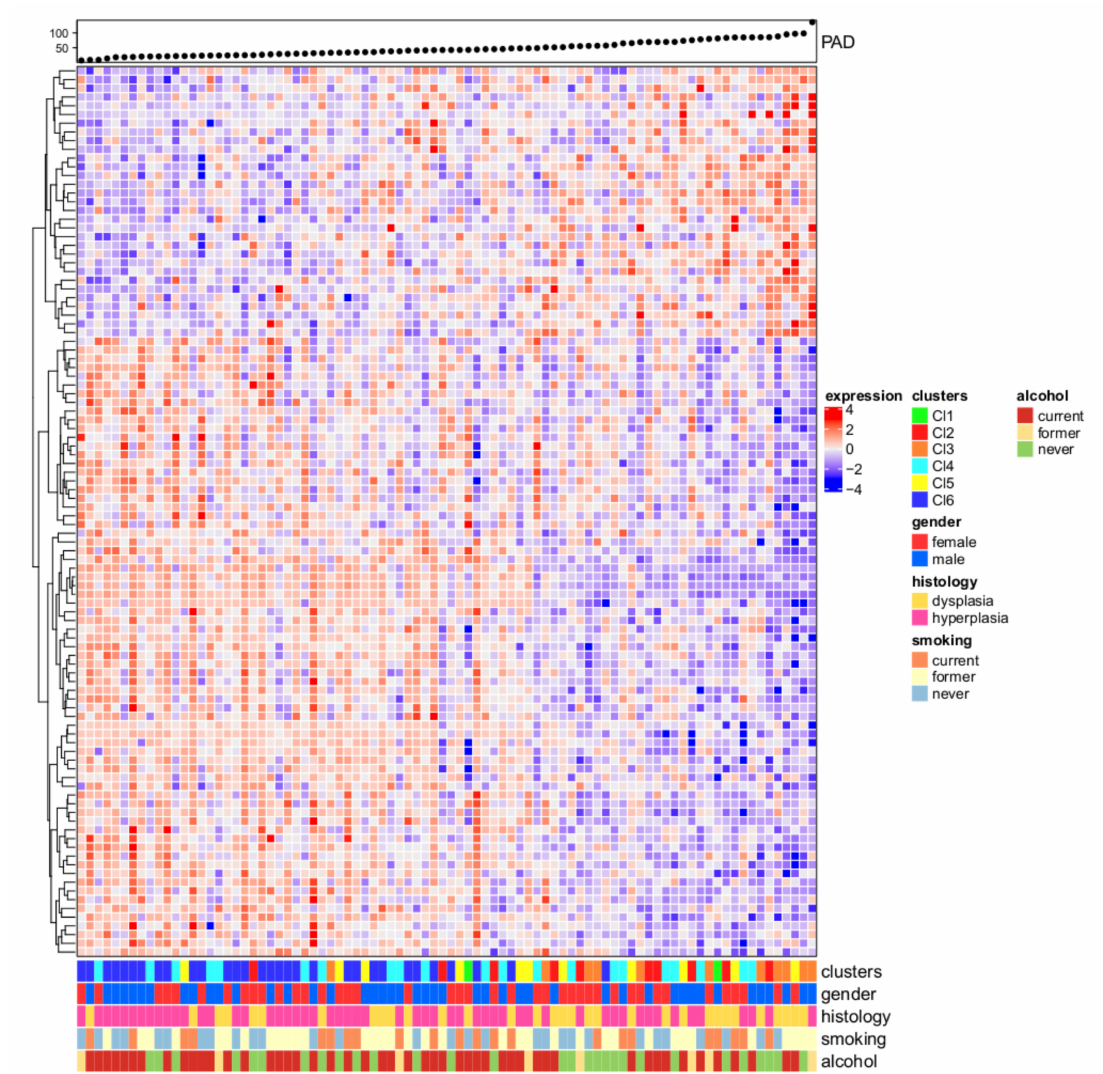
Figure 2. Progression analysis of disease (PAD). The upper panel shows the PAD score and the samples were ranked based on the increasing score. Low score values correspond to expression profiles close to the normal state; on the opposite, as the score values increase, the molecular di ff erences compared to the normal state increase. The heatmap depicts the normalized gene expression values of 102 genes (rows) associated with the PAD procedure for the 86 OPL samples (columns) in a color scale ranging from blue to red, corresponding to low and high expression, respectively. On the bottom panel, five features were reported in a bar plot to highlight their association with increasing scores (i.e., cluster membership, gender, histology, smoking, and alcohol